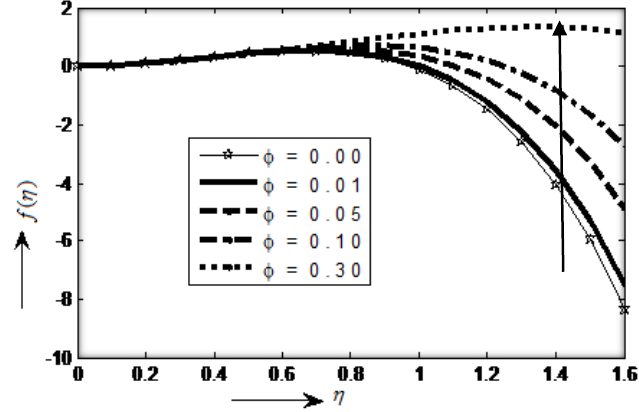
Figure 7. Variation of fluid velocity f (  ) against  for slip coefficients  (0.0, 0.01, 0.05, 0.10, 0.30) by taking parameters M = 2, K = 0.8 and Re = 0.1